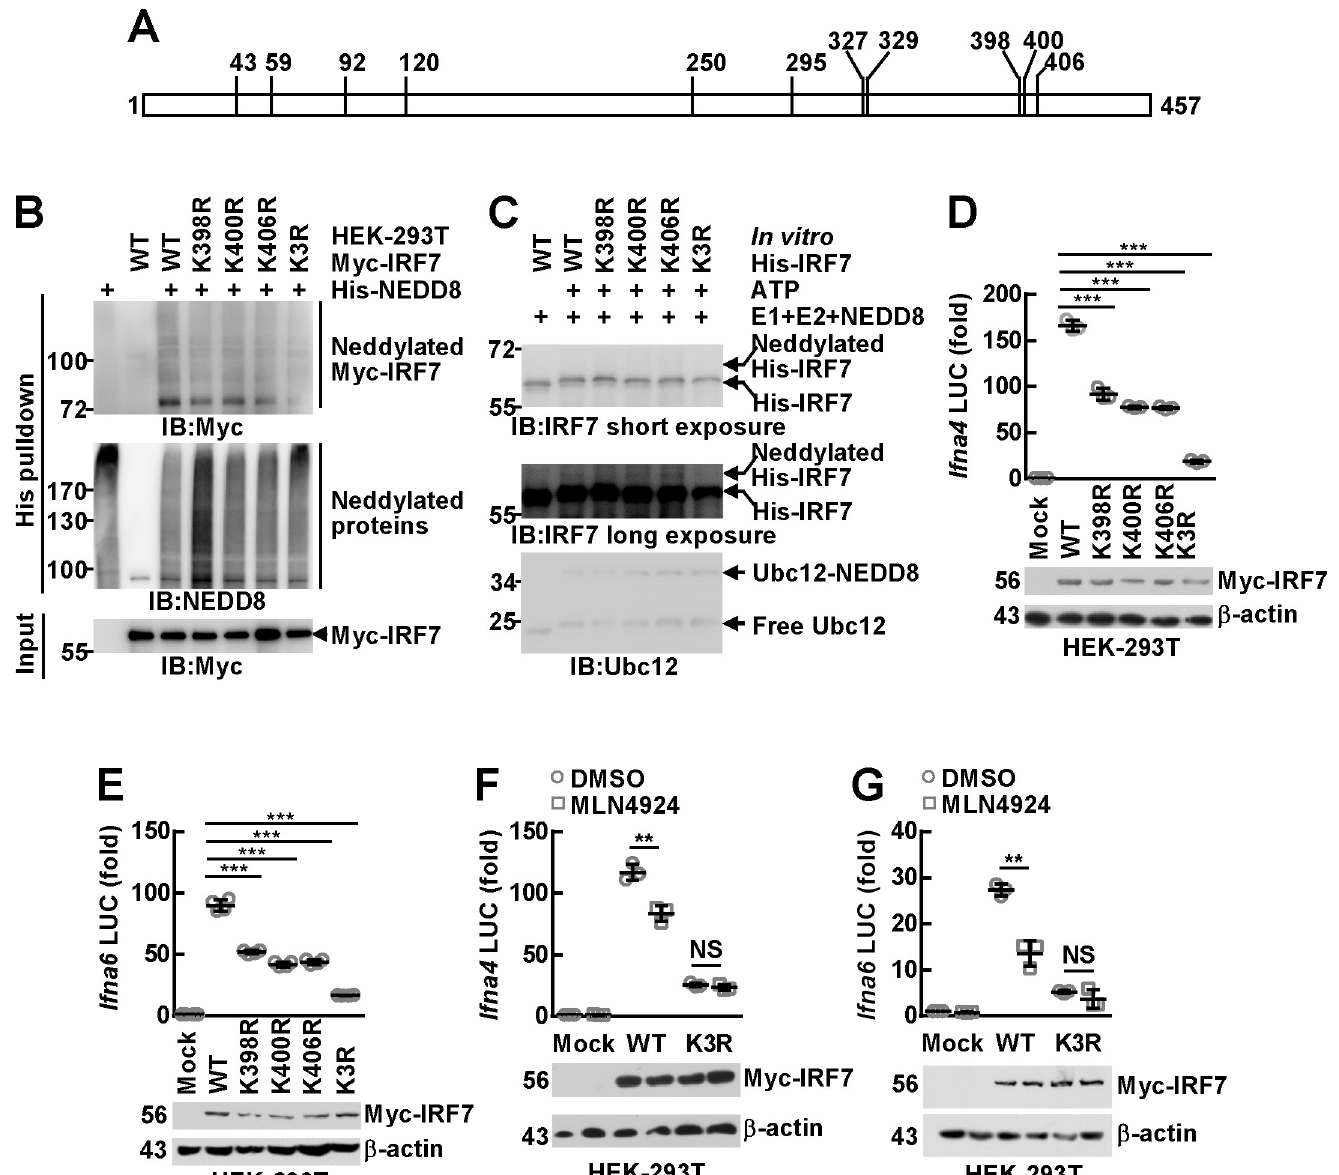
Fig 5. The transcriptional activity of mammalian IRF7 depends on covalent attachment of NEDD8 to its C-terminal lysines. (A) A schematic representation of all the lysine residues in murine IRF7. (B) HEK-293T cells were transfected with mammalian expression vectors encoding His-NEDD8 and FLAG-Myc-tagged murine IRF7 WT or mutants. Twenty-four hours later, the neddylation of exogenous murine IRF7 was examined by IB analysis with the indicated antibodies after histidine pulldown under fully denaturing conditions. (C) Bacterially expressed His-tagged murine IRF7 WT or mutants were subjected to in vitro neddylation (37˚C, 1 h), followed by IB with the indicated antibodies. (D-G) FLAG-Myc-tagged murine IRF7 WT and mutants were co-transfected with reporter plasmids driven by Ifna4 promoter or Ifna6 promoter in HEK-293T cells. After 12 h, the cells were treated with 0.5 μ M MLN4924 for another 24 h or left untreated. Dual-reporter luciferase (LUC) assays were then performed with the supernatants. Luciferase activity was reported as fold induction ( Top ). Cell lysates were subjected to IB analysis with antibodies against Myc tag and β -actin ( Bottom ). Quantitative data are shown as Mean ± SD ( n = 3 ~ 4 per group). �� p < 0.01; ��� p < 0.001; NS, not significant.